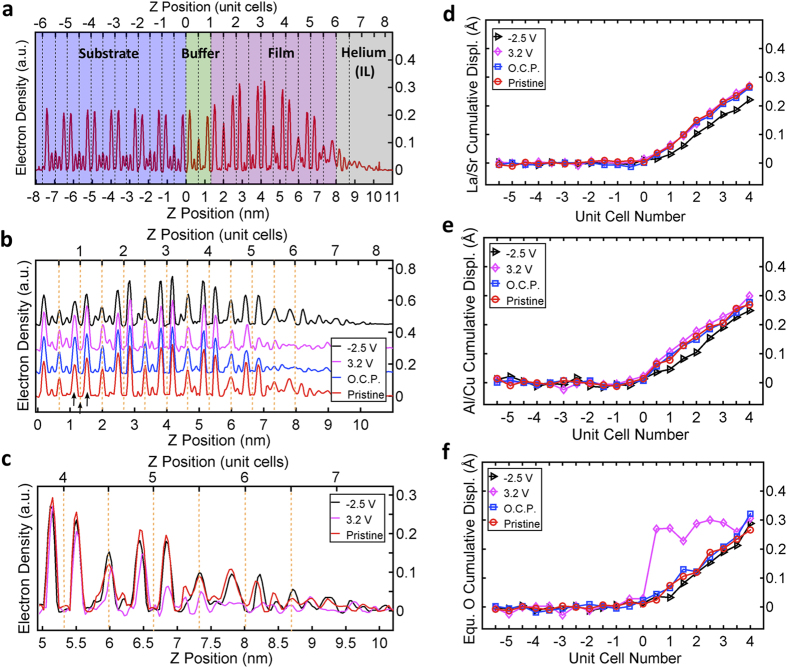
The electron density profiles and atomic displacements determined by COBRA, for various bias voltage conditions.In the figure legends, O.C.P. = open circuit condition. (a) The electron density profiles and atomic displacements determined by COBRA for the pristine sample along the [0 0 Z] atomic columns of the unit cell. The electron densities are graphed as a function of Z (nm) and Z (unit cells). Z = 0 nm (unit cells) is the position of the geometric interface between the substrate and the 1 UC buffer. For the substrate, the conversion is 1 unit cell = 1.262 nm, while for the film, we used the average film lattice spacing 1 unit cell = 1.315 nm. The substrate, buffer, film, and helium regions are indicated for the pristine sample, for other cases helium is replaced by the IL. Note that the last unit cell before the film-helium interface is incomplete or exhibits only partial registry with the substrate. (b) An expanded view within the buffer, film, and helium region. Notice the pronounced difference between the data for Vg = 3.2 V and Vg = −2.5 V bias voltage conditions, and the similarity between the data for open circuit and Vg = 3.2 V conditions in the region of Z > 6 nm. (c) An expanded view of the electron density profile in the region of 5 nm < Z < 10 nm. The average cumulative displacements (d) of La/Sr atoms above and below Cu, (e) of the Cu atoms, and (f ) of the equatorial oxygen (OP) atoms measured for the atoms in each half unit cell with zero indicating the substrate/buffer interface. All cumulative atomic displacements are relative to a reference grid composed of the La/Sr and Al substrate atoms and extended throughout the entire sample. The slope in the displacement curves indicates that the size of unit cells above the substrate/film interface is larger than that of the substrate by 0.065 nm/unit cell on average.